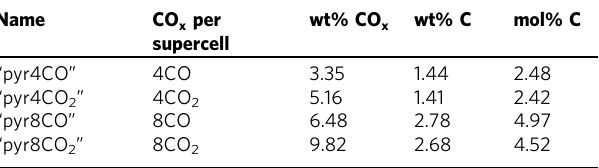
Table 2 Carbon species added to pyrolite melt